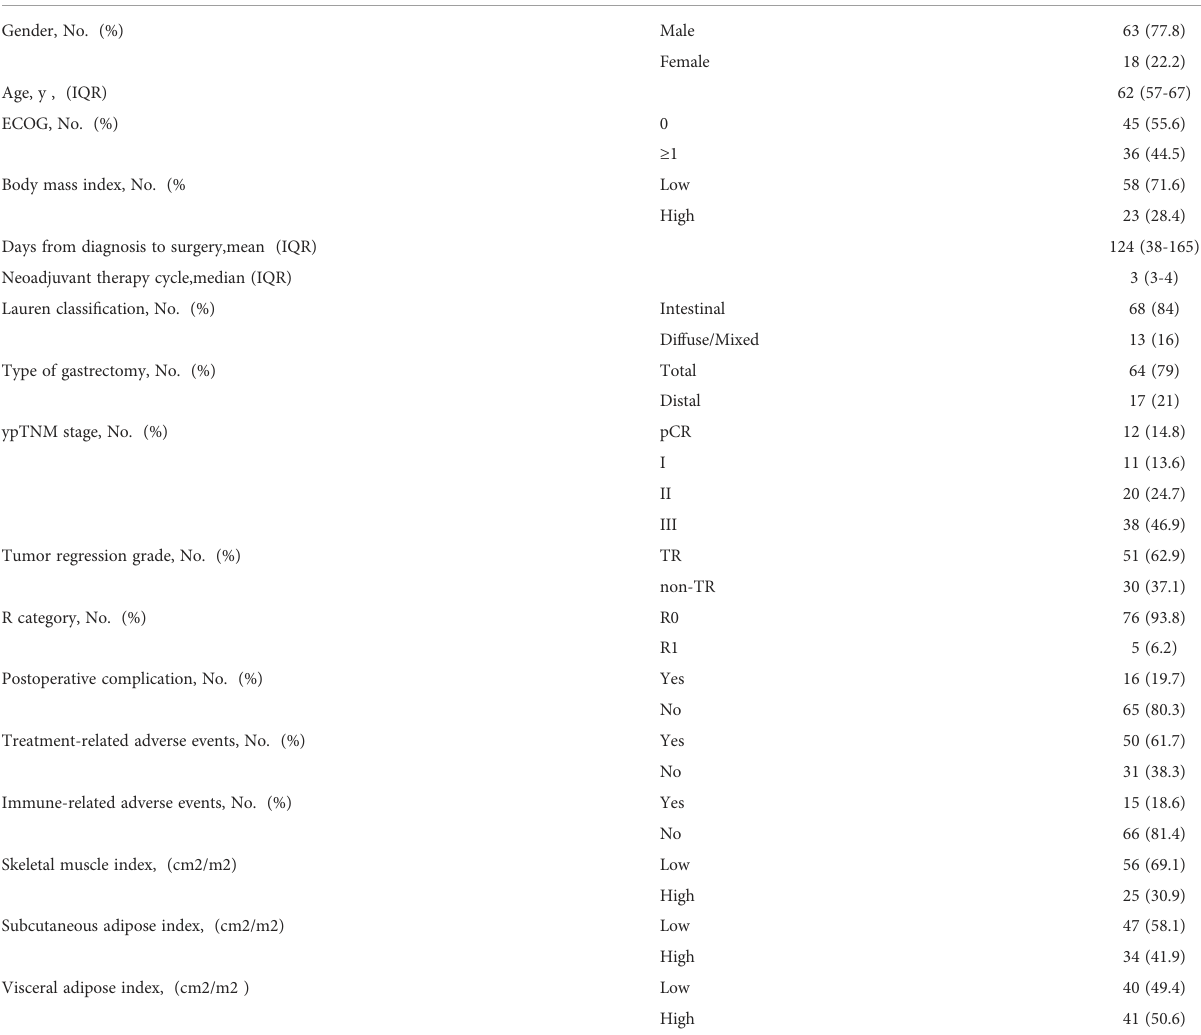
TABLE 1 General characteristics of patients.